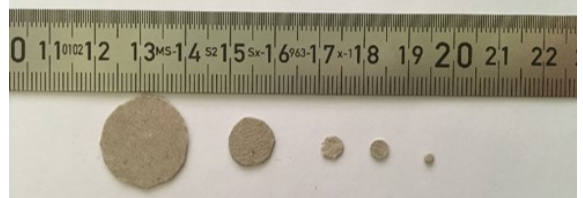
Figure 1. Flaw imitations with a diameter of 20, 10, 5, 4, and 2 mm, from left to right, with a thickness of 0.6